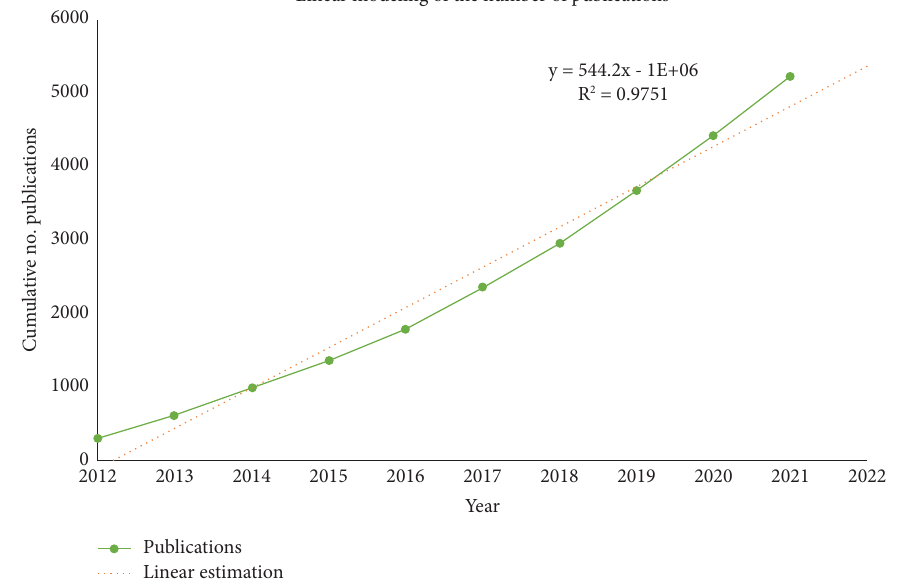
Figure 4: Linear modeling of the cumulative number of publications related to acute postsurgical pain,